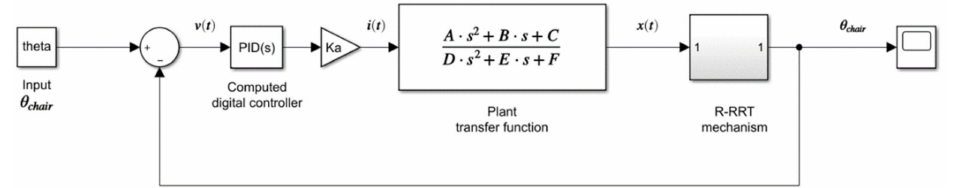
Figure 16. Experimental wheelchair position